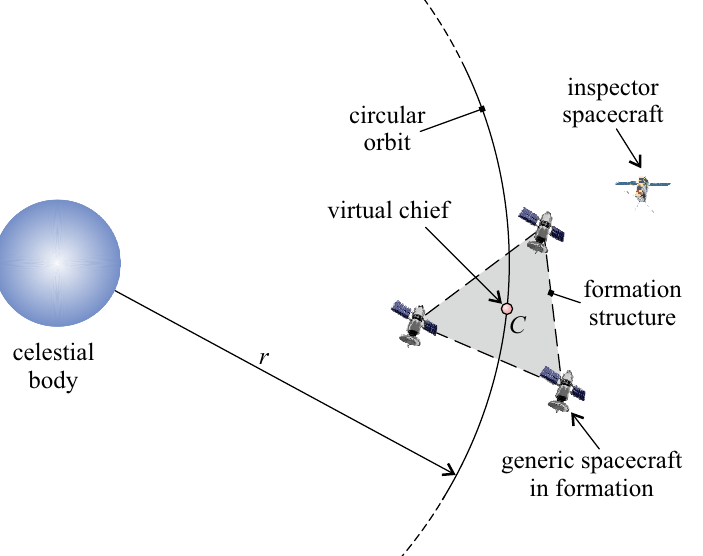
Figure 1. Conceptual sketch of a formation with three vehicles and a CubeSat inspector